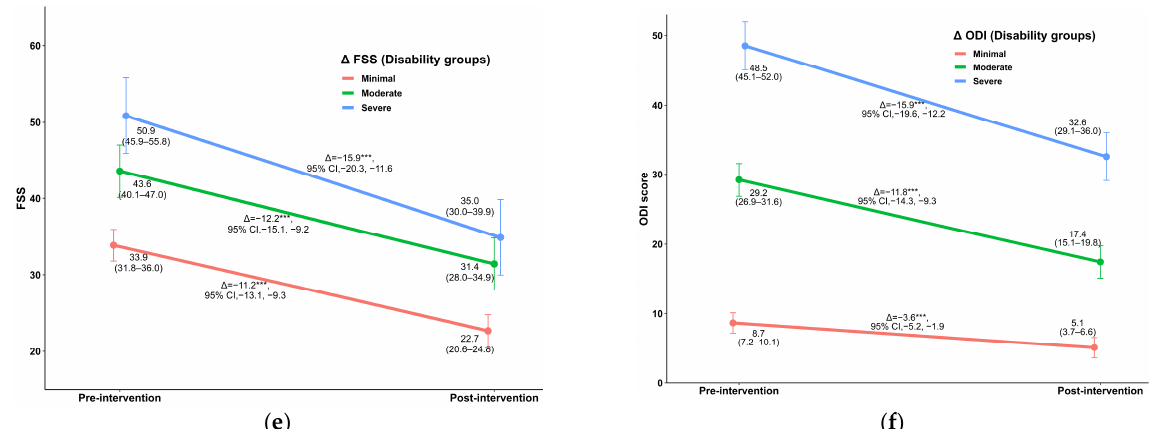
Figure 1. Improvements in outcome variables across the three disability groups (mean, standard error of the mean): ( a ) body weight loss; ( b ) fat-free mass; ( c ) fat mass; ( d ) stair climbing time ( e ) fatigue severity scale ( f ) Oswestry disability index. *** p < 0.001; CI—confidence interval; mean values (standard error of the mean); Δ—changes between pre and post intervention; FSS—fatigue severity scale; ODI—Oswestry disability index; an age-and-gender-adjusted two-way repeated measures ANOVA was used to determine changes in the parameters between pre and post intervention.